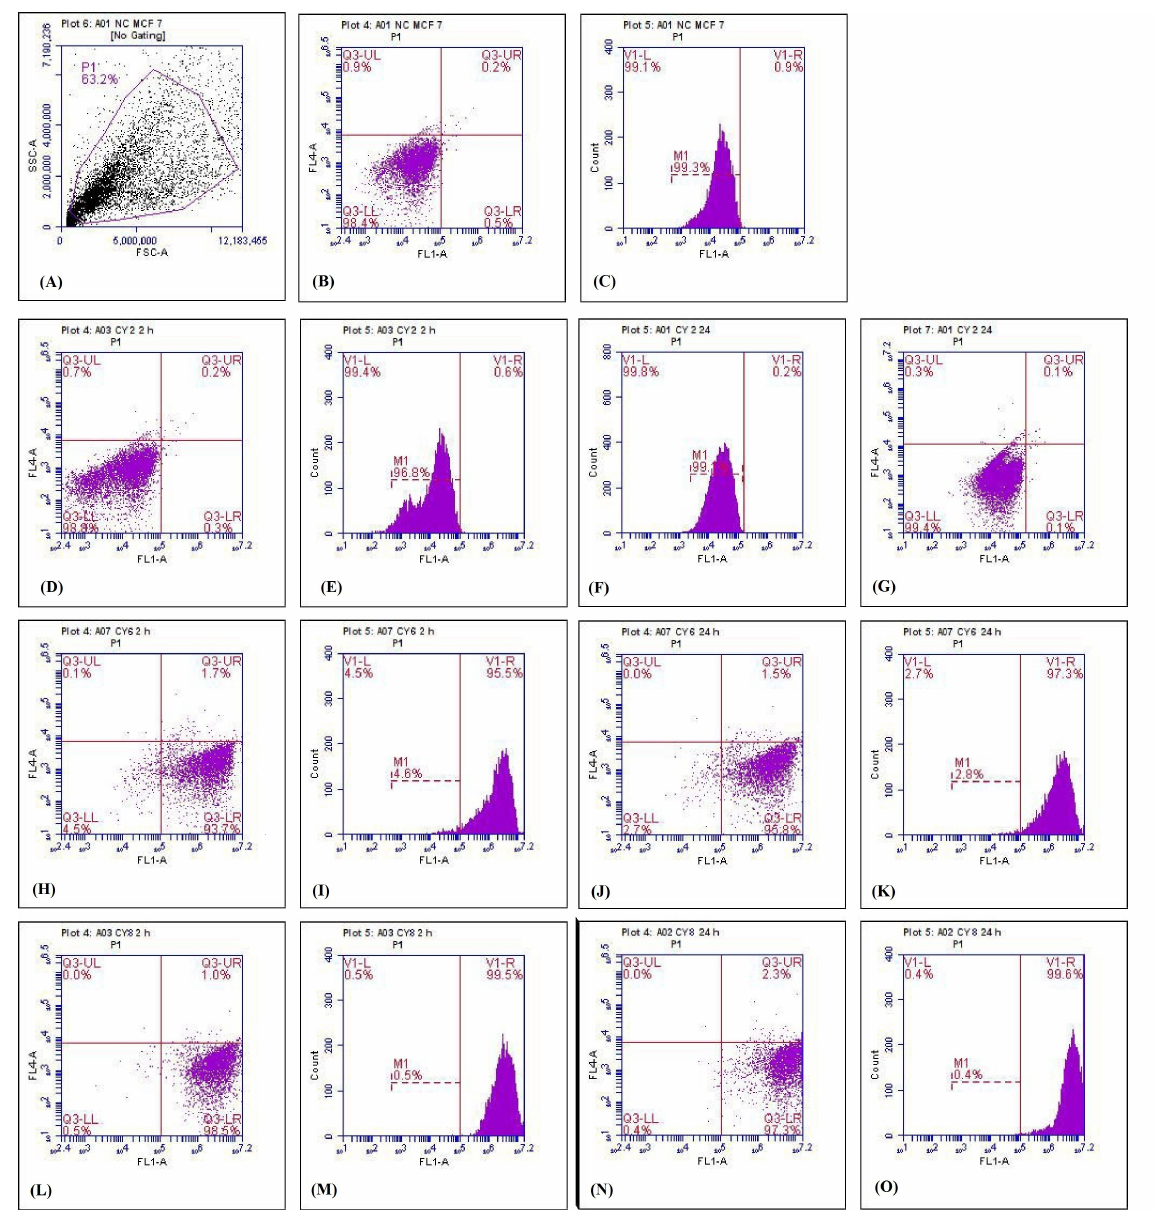
Figure 7. Cellular uptake study using flow cytometry: ( A ) gating, ( B , C ) fluorescence of untreated MCF-7 cells, ( D , E ) fluorescence of blank nanoparticles at 2 h, ( F , G ) fluorescence of blank nanoparticles at 24 h, ( H , I ) fluorescence of unconjugated nanoparticles at 2 h, ( J , K ) fluorescence of unconjugated nanoparticles at 24 h, ( L , M ) fluorescence of DCT-loaded T f -conjugated PLGA NPs at 2 h, ( N , O ) fluo- rescence of T f -conjugated PLGA NP at 24 h. The x - and y -axes correspond to forward scatter (FSC) (which measures size) and side scatter (SSC) (which measures internal complexity), respectively. The FL1-area stands for total cell